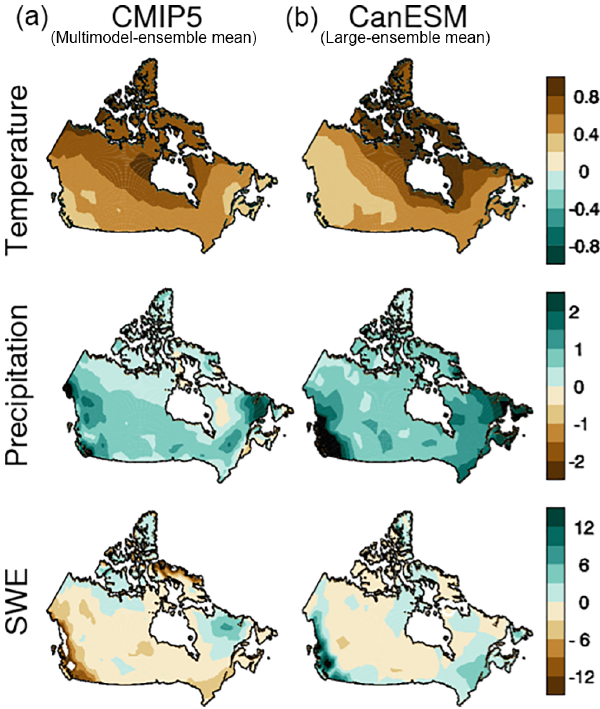
Figure 7. Column (a) shows the multimodel mean of CMIP5 trends over the 1981–2005 historical period for JFM land-surface tempera- ture, precipitation, and SWE. Column (b) shows the corresponding multi-realization mean for the CanESM2 large ensemble. Unlike Figs. 5 and 6, the spatial mean of the trend has not been